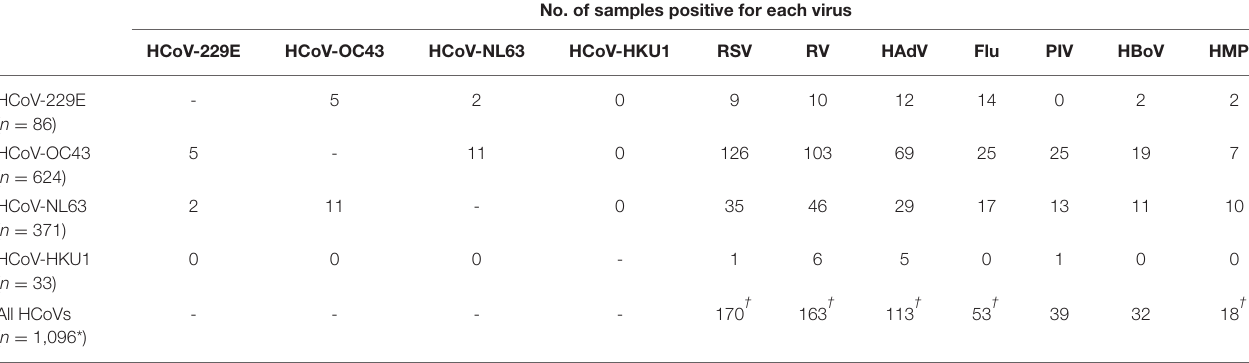
TABLE 1 | Frequency of viral detections from January 2015 to December 2019.